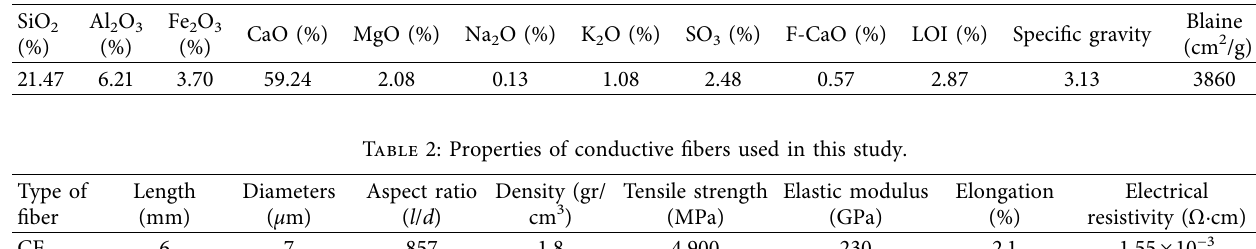
Table 1: Physical properties and chemical compositions of used cement.